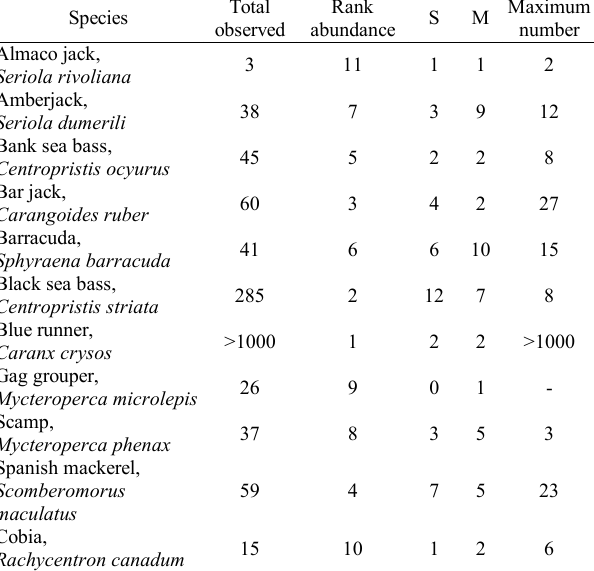
Table 1. Piscivorous reef fish species observed at Anchor